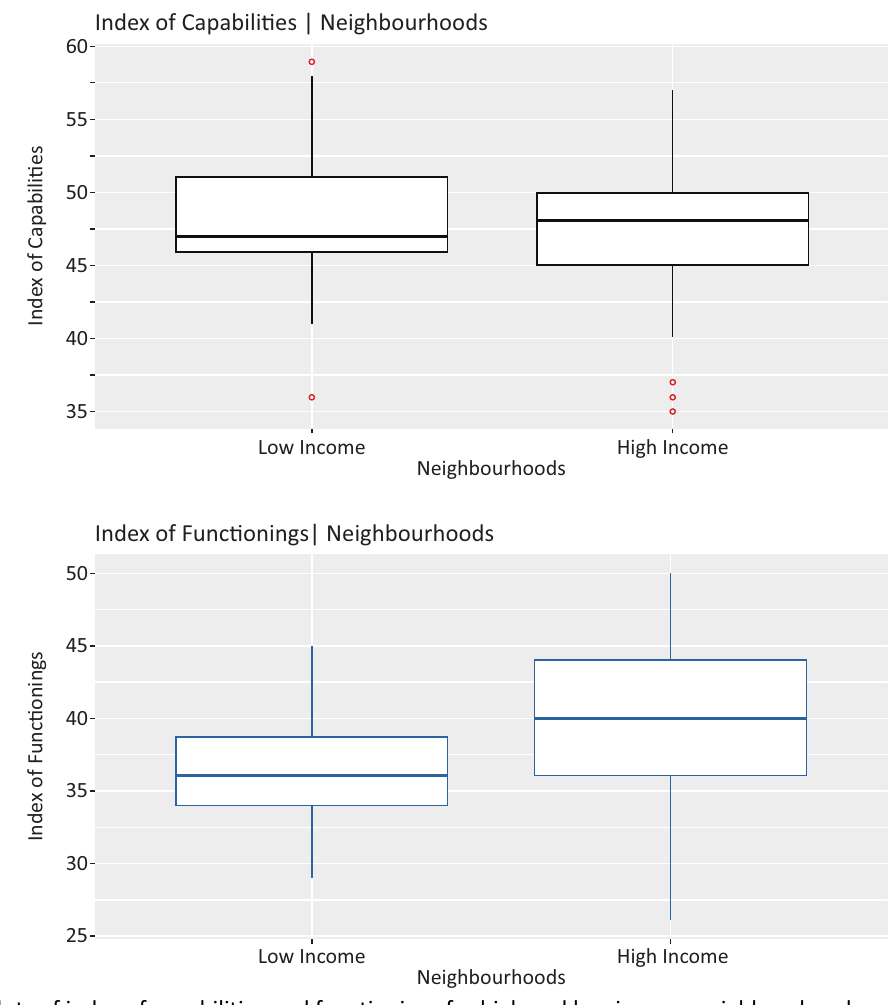
Figure 5. Box plots of index of capabilities and functionings for high and low income